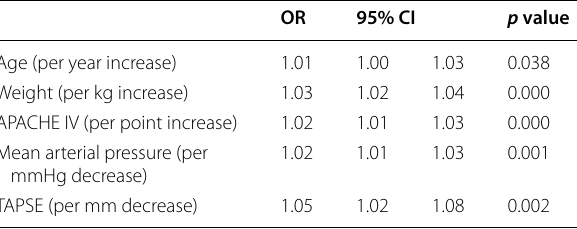
Table 2 Variables independently associated with the development of AKI in multivariable analysis